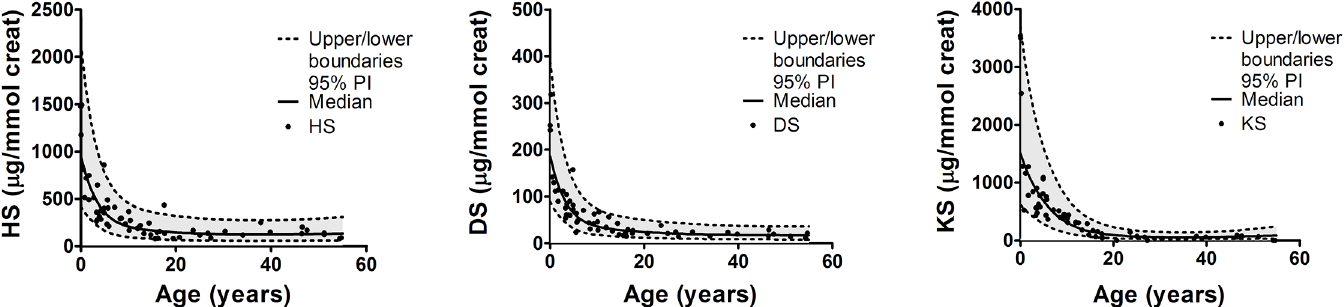
Fig 1. Modeled reference ranges for HS, DS, KS in urine. Individual data points of healthy controls are presented for HS, DS and KS as determined by the LC-MS/MS. Dashed lines indicate the boundaries of the 95% prediction interval. The upper limit of the 95% prediction interval is considered the upper limit of normal in this